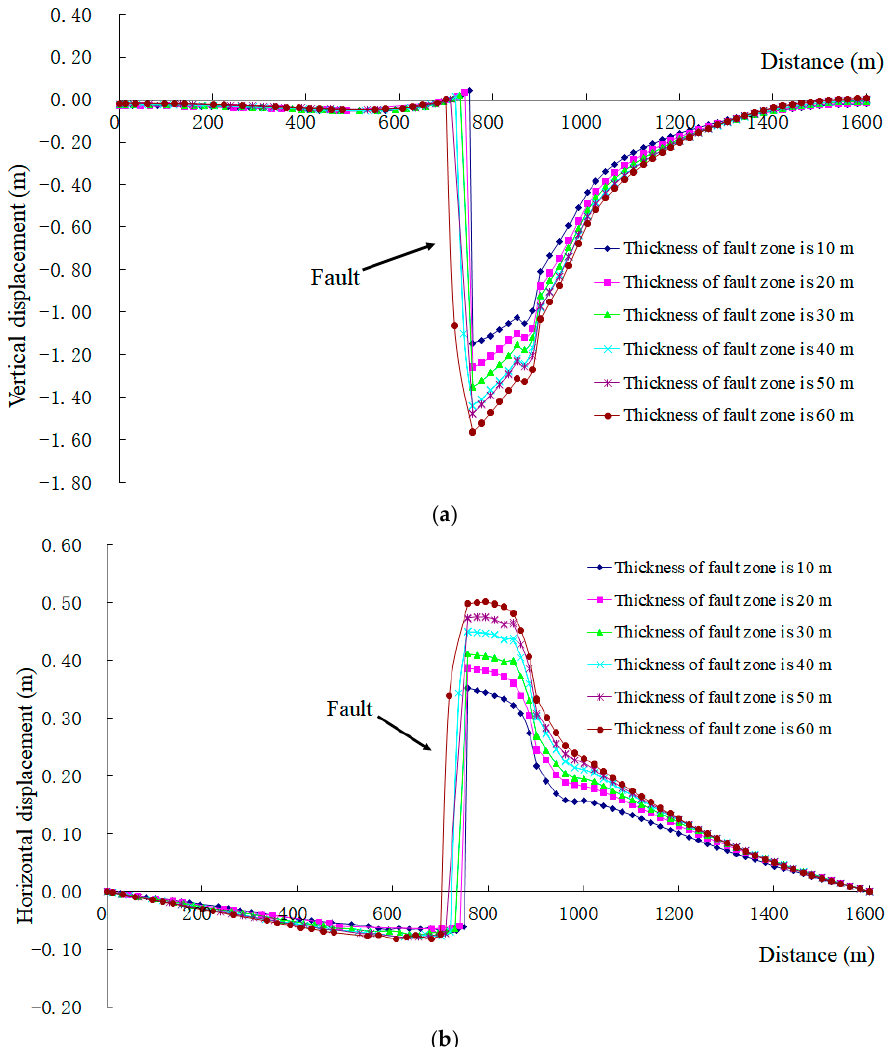
Figure 23. Displacement distribution of monitoring lines under different fault zone thicknesses, they should be listed as: ( a ) Vertical displacement; ( b ) Horizontal displacement. should be listed as: ( a ) Vertical displacement; ( b ) Horizontal